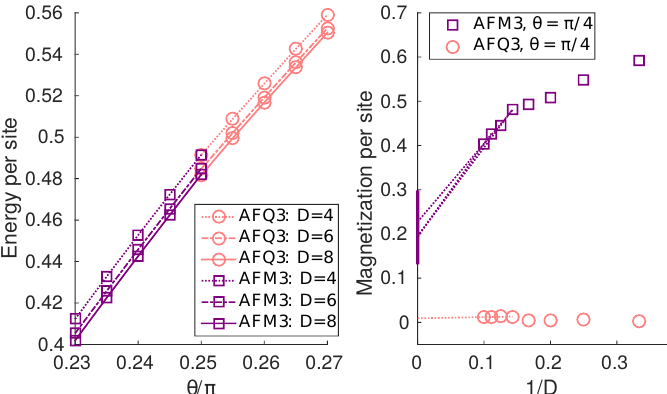
Figure 10: Energy per site (left) and magnetization per site (right) for the 120° magneti- cally ordered (AFM3) and the antiferroquadrupolar (AFQ3) states near the phase transition at θ = π/ 4. By carefully comparing the slopes of both graphs, we observe a very subtle kink in the energy as a function of θ for each fixed D (only D = 4,6,8 plotted; more clutters the figure), and the extrapolated magnetization (plotted for D = 3,4,...,10) jumps from m > 0.1 (AFM3) to m ≈ 0 (AFQ3), indicating a first order